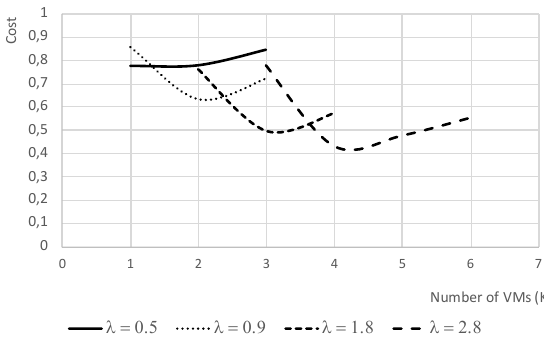
Figure 6. Trade-off between deployment cost (number K of VMs) and user satisfaction for different arrival rates λ